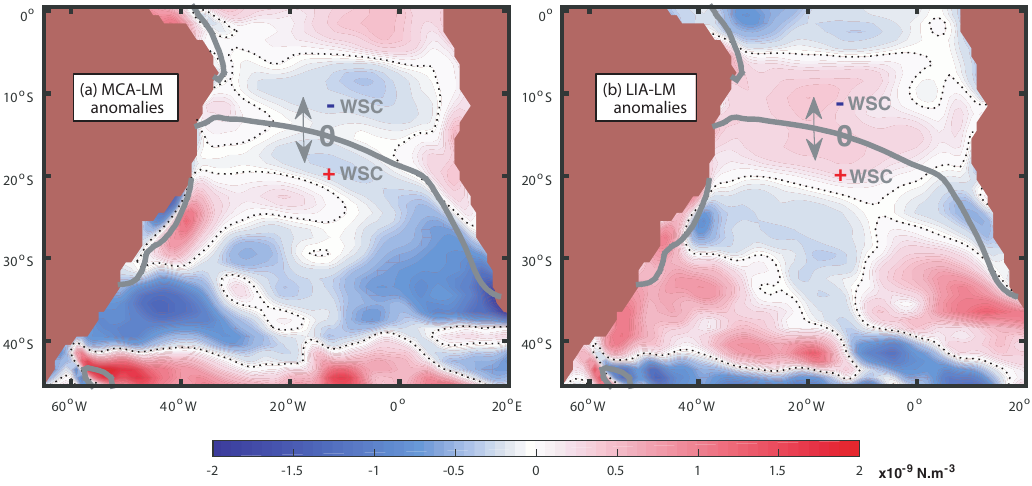
Figure 6. Wind stress curl (WSC) anomalies ( × 10 − 9 N · m − 3 ) with respect to the whole-LM base period (850–1849). ( a ) For the MCA, between 950 and 1249, and ( b ) for the LIA, between 1400 and 1699. The black dashed contours mark the division between positive (red) and negative (blue) anomalies. The gray solid line denotes the LM-mean zero wind stress curl line, north (south) of which the WSC is negative (positive), i.e., cyclonic